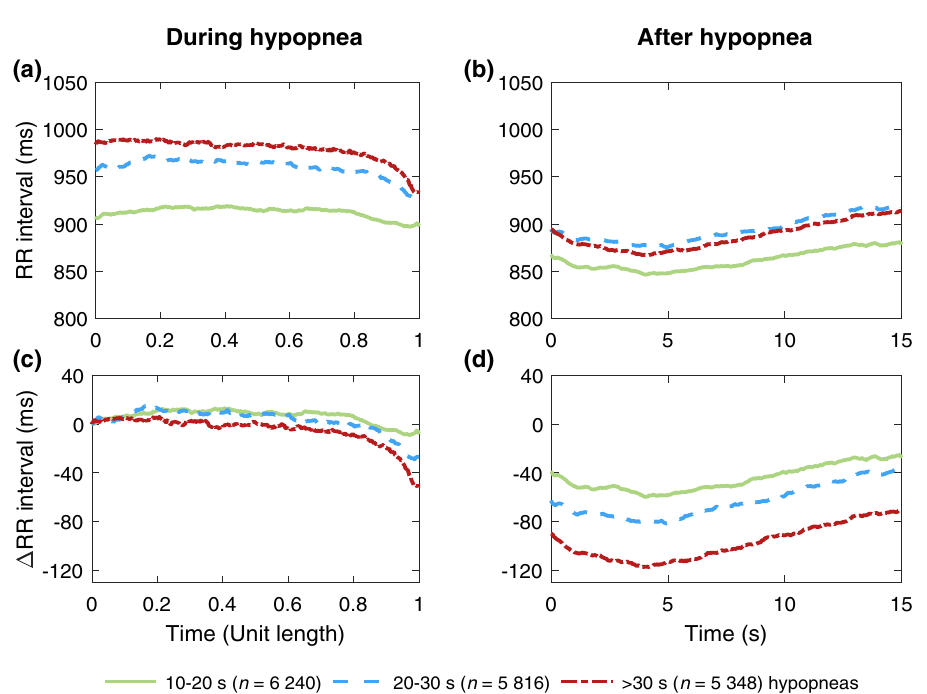
Figure 2. Median RR intervals of men ( n = 395) ( a) during hypopneas of different durations ( n = 17 404) and ( b) during a 15-s segment following hypopneas. The absolute changes in RR intervals relative to the beginning of the event during and after hypopneas are presented in subfigures ( c) and ( d) , respectively. In subfigures ( a) and ( c) the duration of every hypopnea event is normalized with its